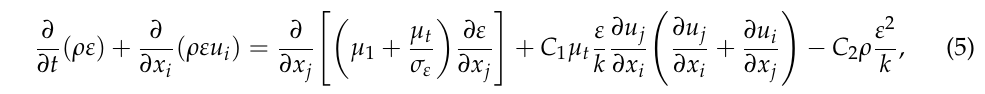
Figure 6. Grid around